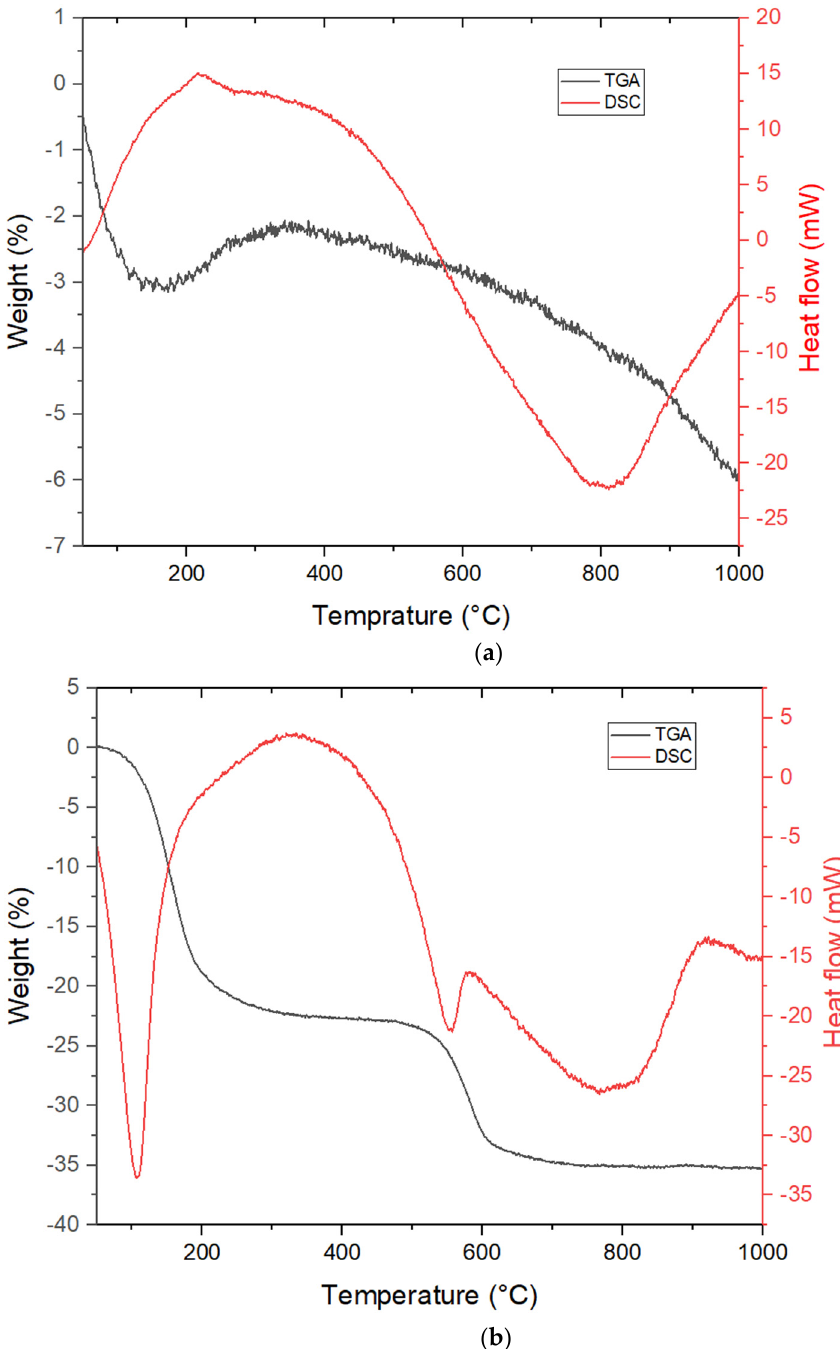
Figure 5. TGA/DSC thermogram of ( a ) TS0 and ( b ) TS-3-400.